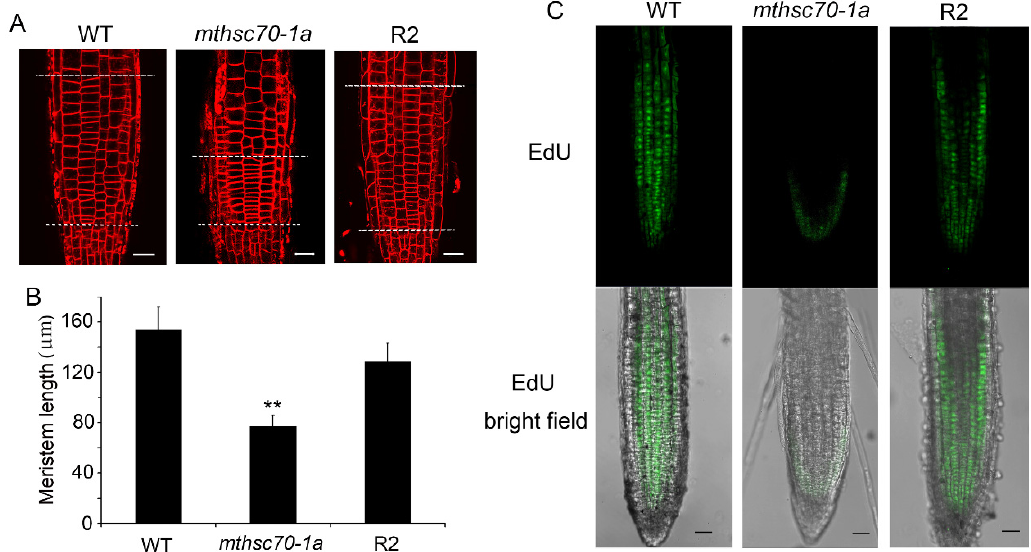
Figure 2. mtHSC70-1 knockout decreased the meristem length and mitosis activity in root tips. ( A ) The cell files of primary root tips by FM4-64 staining. The roots of 5 days old seedlings were observed using a LSCM. Representative images are shown. The cells without obvious elongation in the stele area were used as the standard of meristem cells in this experiment. The zones between two white dotted lines were measured. ( B ) Meristem lengths of the primary root tips. The data are the means ± SD of 30 roots. The experiments were repeated three times with similar results. The asterisks indicate significant differences from WT ( t- test, **, p < 0.01). ( C ) Results of S-phase entry of primary root tips by EdU staining. The roots of 6 days old seedlings were observed using a LSCM. Representative images are shown. Top row, EdU staining; bottom row, merge of EdU fluorescence and bright field. WT, wild-type; mthsc70-1a , a mtHSC70-1 mutant line; R2, a complementary mthsc70- 1a line. Scale bar = 20 μ m. Figure 3. mtHSC70-1 knockout decreased the auxin response in primary root tips. ( A – E ) Detection of GUS activity. Roots of 5 days old Col/ DR5:GUS ( A , B ) or mthsc70-1a/DR5:GUS ( C , D ) seedlings were incubated in GUS dye liquor and observed using a stereomicroscope. Representative images are shown. Figure ( B , D ) are enlarged views of the rectangular frames in Figure ( A , C ), respectively.